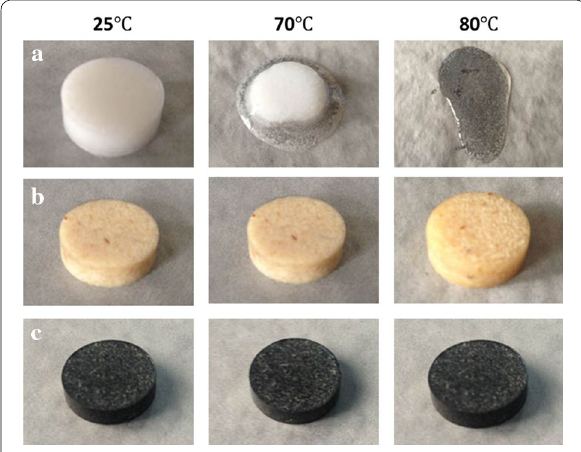
Fig. 7 Shape‑stable images of a PEG, b CPCMs‑4, and c CPCMs‑4 with 5% EG